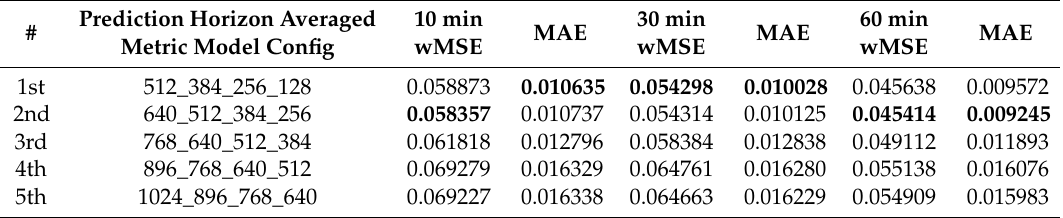
Table 1. Comparison of prediction metrics by different configurations of DCPN. Minimum wMSE values marked in bold.